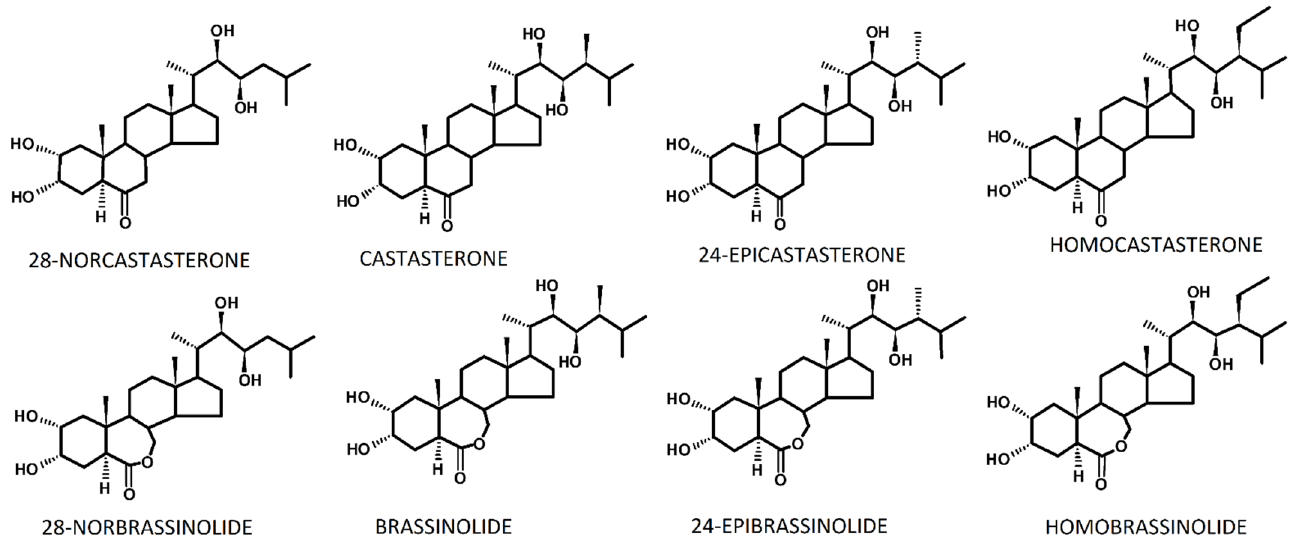
Figure 1. Structural formulas of the selected BR: C 27 (28-norcastasterone, 28-norbrassinolide), C 28 (castasterone, brassinolide and 24-epicastasterone, 24-epibrassinolide) and C 29 (homocastasterone, homobrassinolide). Figure was prepared in ChemSketch program and is based on the chemical structures of BR that are available in an article of Bajguz and Tretyn